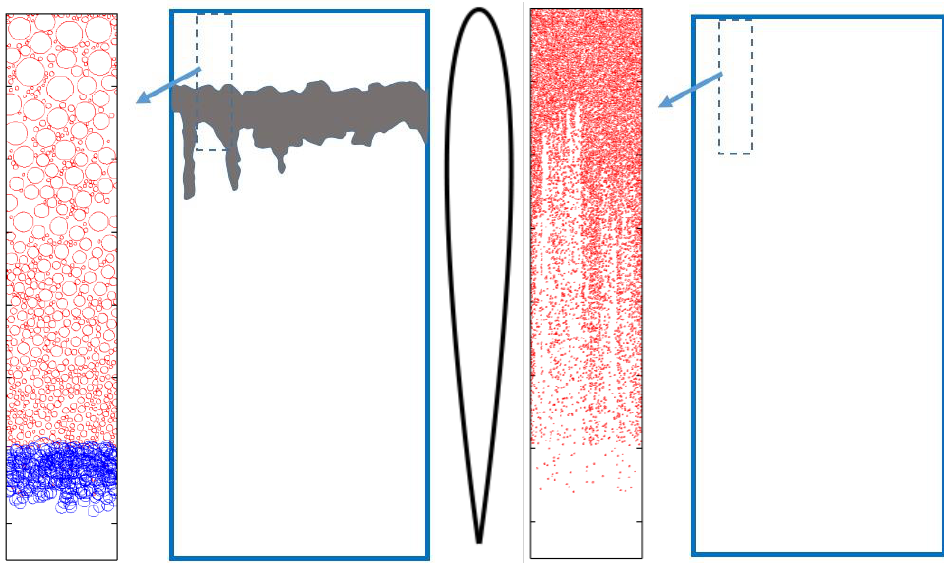
Figure 8. Computed results: red, liquid droplets. Blue, frozen beads. Experimental data, recon- structed from [29]: dark grey: iced area. Left, hydrophilic leading edge on an otherwise hydrophobic coated airfoil. Right, fully hydrophobic coated airfoil.